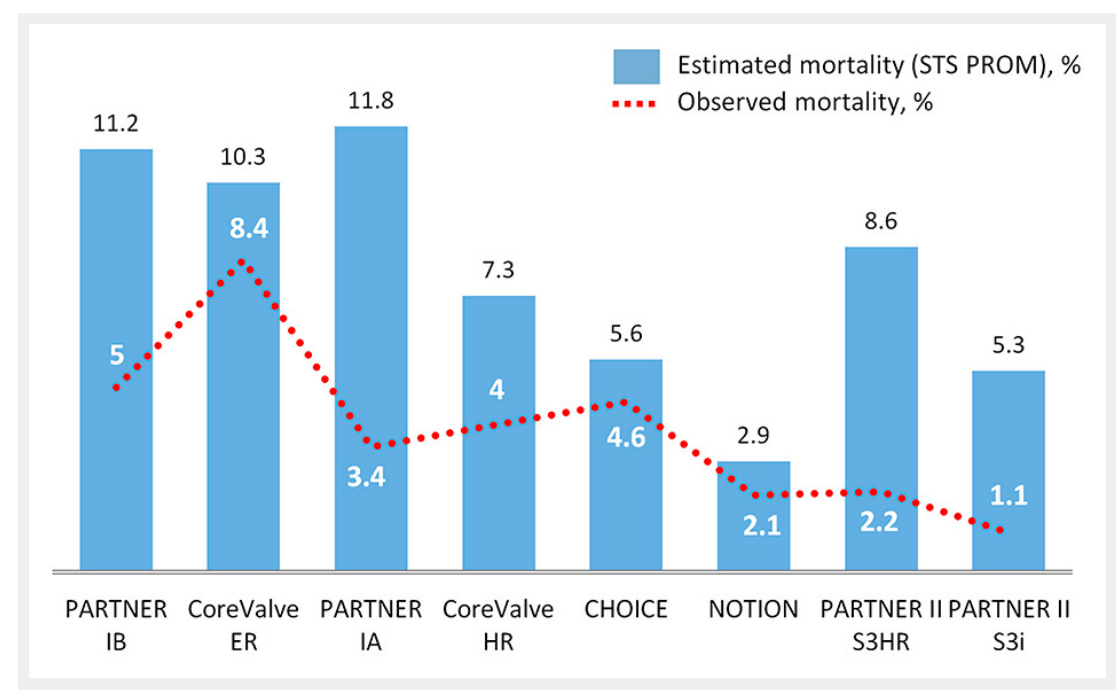
Estimated and observed all-cause 30-day mortality after TAVI in randomised trials and FDA approval studies (ordered according to the date of publication). Bar graph with the estimated risk of mortality according to the STS PROM risk score and the observed risk of mortality after transcatheter aortic valve implantation at 30-day follow-up in randomised trials and large-scale FDA approval studies. HR = high risk; ER = extreme risk; I = intermediate